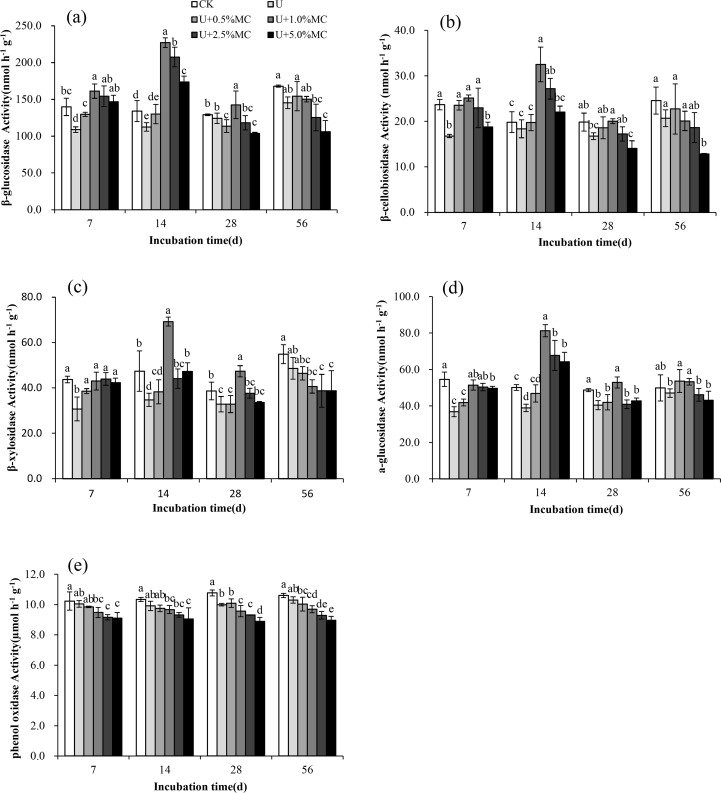
Response of C-cycle enzyme activities to additions of biochar and urea during a 56-day incubation.(a) β-glucosidase activity, (b) β-cellobiosidase activity, (c) β-xylosidase activity, (d) α-glucosidase activity and (e) phenol oxidase activity. Vertical bars represent the standard error of the means (n = 3) and lower case letters indicate significant differences between treatments at the P< 0.05 level.